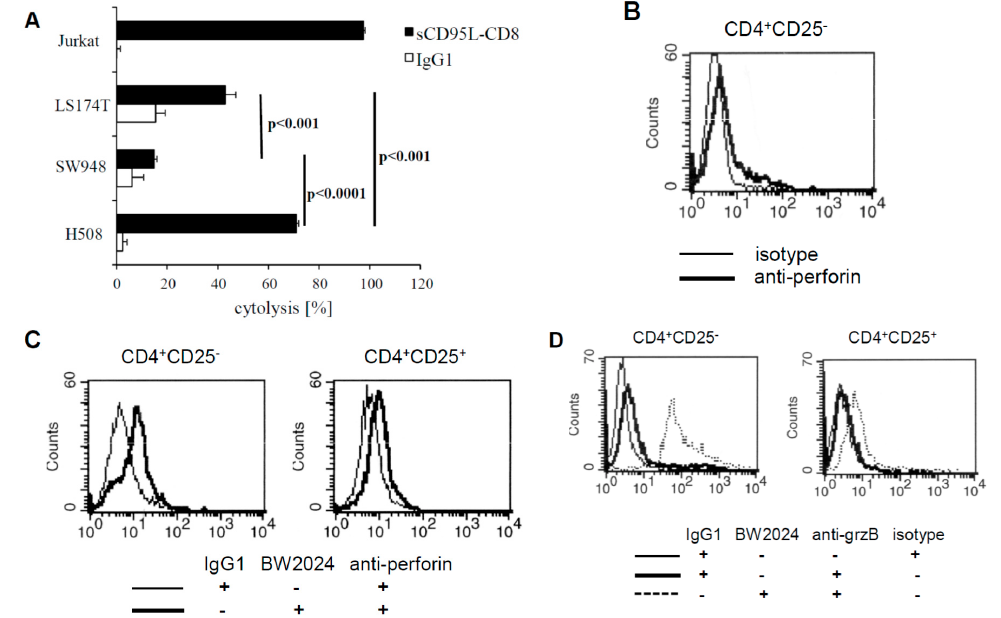
Figure 6. Susceptibility of target cells for FasL mediated cell death. ( A ) CEA + LS174T, SW948 and H508 tumor cells and CEA − Jurkat cells for control were incubated in 96-well micro-titer plates in the presence of recombinant CD8-Fas-L fusion protein (2 µ g/mL) for 24 h. The viability of tumor cells was determined by the XTT assay and specific cytolysis calculated. Data represent mean of technical replicates + SD. Significant differences were calculated by the Student’s t test. A representative experiment out of three is shown. ( B ) Resting CD4 + CD25 − T cells express low levels of perforin. CD4 + CD25 − CAR T cells were cultured without stimulation for 48 h and tested by flow cytometry for intracellular perforin levels. An isotype matched mAb served as control for staining. ( C , D ) Perforin and granzyme B were upregulated in CD4 + CD25 − but not in CD4 + CD25 + CAR T cells upon CAR stimulation. CD4 + CD25 − and CD4 + CD25 + CAR T cells (2.5 × 10 4 /well) were stimulated in micro-titer plates coated with 10 µ g/mL anti-idiotypic mAb BW2064 or with an isotype control IgG1 for 48 h. Cells from triplicates were pooled, stained with anti-perforin ( C ) or anti-granzyme B ( D ) mAbs, and recorded by intracellular flow